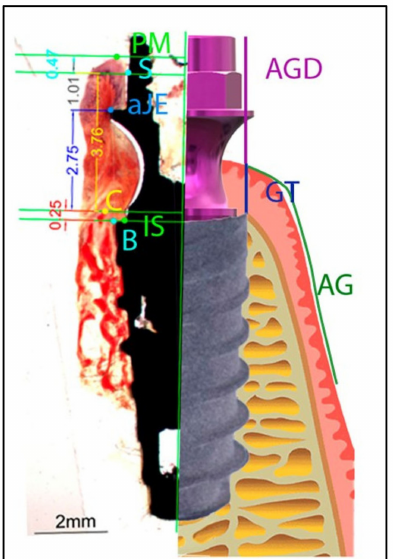
Figure 3. Diagram illustrating the landmarks for histomorphometric evaluation and the clinical measures: IS, implant shoulder; B, most coronal bone-to-implant contact location; C, the top of the alveolar crest; aJE, the apical border of the junctional epithelium; PM, the top of the margin of the peri-implant mucosa; AG, attached gingiva; GT, gum thickness; AGD, abutment to gum